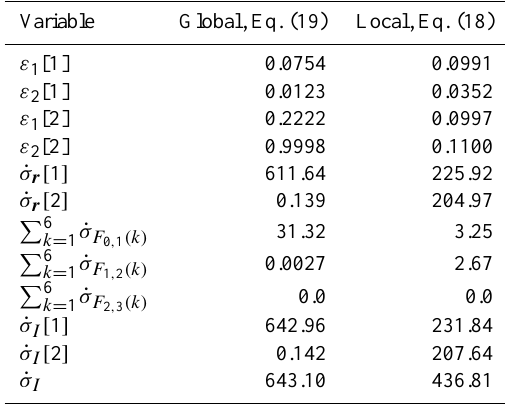
Table 4. Global and local MEP solutions (J m − 2 d − 1 ◦ K − 1 ) based on solutions to Eqs. (19) and (18), respectively.